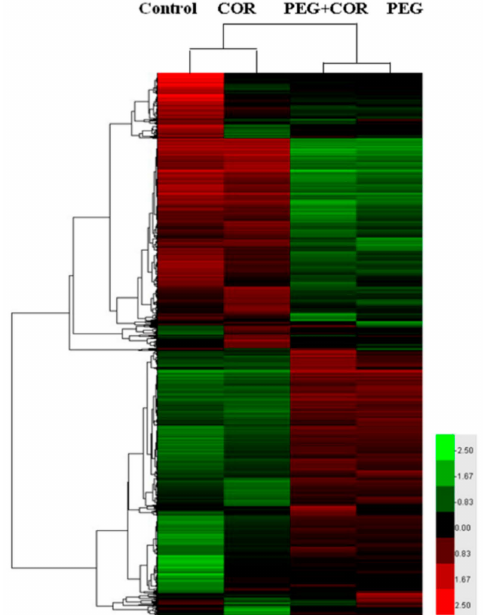
Figure 3. E ff ects of coronatine on the transcriptional profiles of rice leaf blades under drought stress. Cluster analysis of di ff erential display genes response to COR under drought stress condition. Each column represents Log2 ratio (Cy5 / Cy3) of the di ff erent gene. The black color represents the ratio of 1:1; the red is for greater than 1:1.